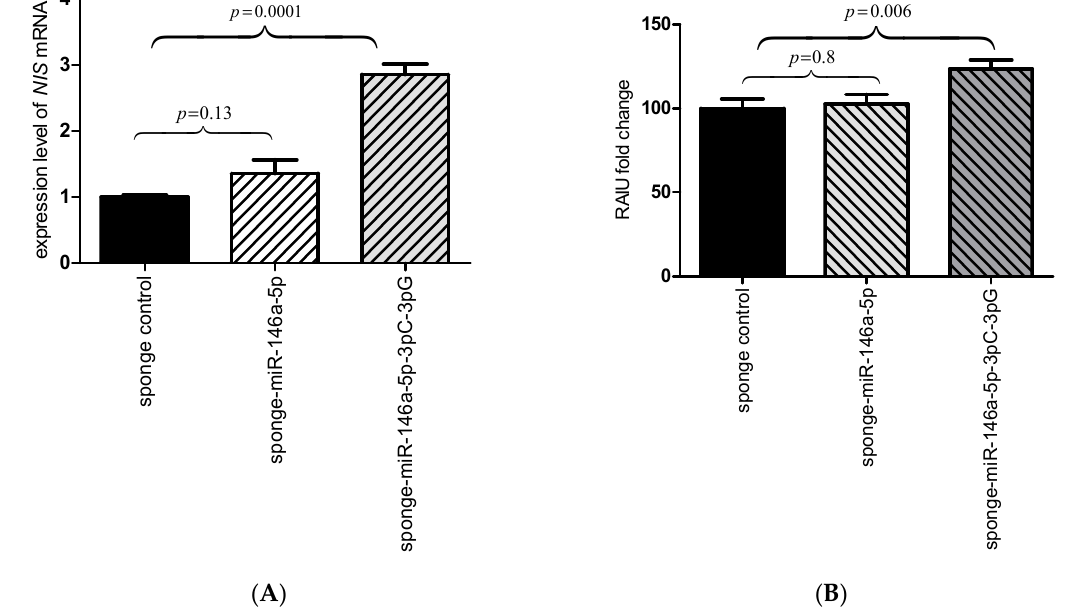
Figure 3. Inhibition of the miR-146a-5p and miR-146a-3p results in upregulation of NIS (sodium-iodide symporter) and increased radioactive iodine uptake. Transfection of the tRA/H treated MCF7 cell line with a sponge miRs and resulting inhibition of both variants of miR-146a-3p, but not miR-146a-5p, leads to a significant increase in NIS mRNA levels (2.86 fold, p = 0.0001). ( A ) and radioactive iodine uptake, RAIU (1.24 fold, p = 0.006); ( B ). the graphs show the mean, along with deviations from mean (SEM). Statistical analysis was performed using an unpaired t test.